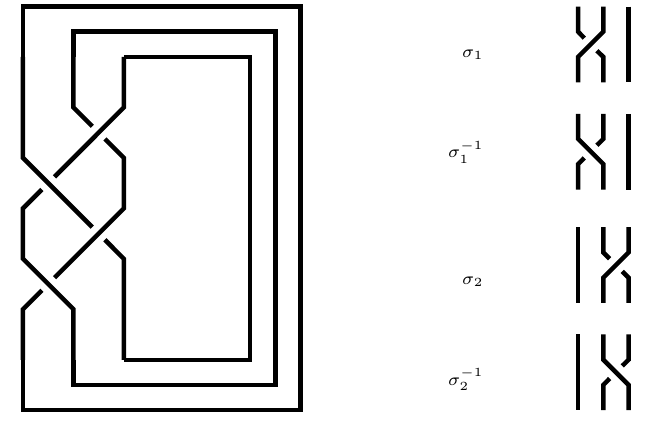
(cid:1) 2 ∈ B 3 . On the right, from top to bottom: σ 1 , σ 1